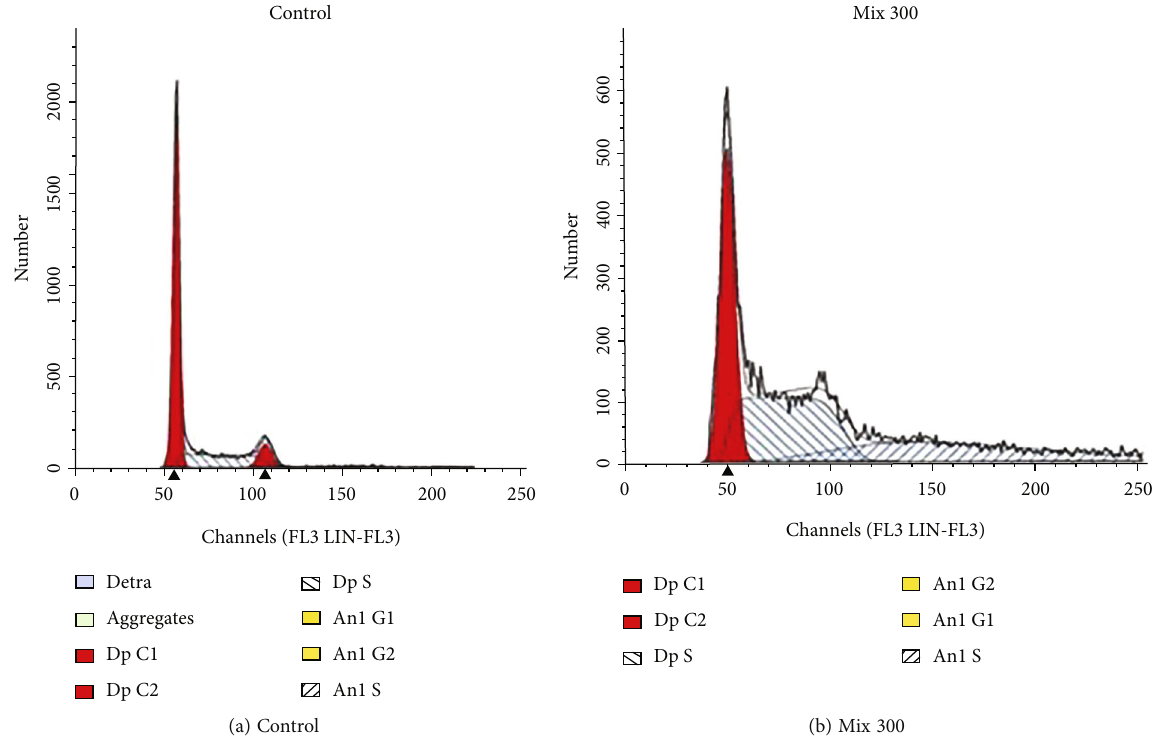
Figure 8: Diploid-tetraploid cycle modeling of representative cell cycle histograms of control (Dip. S: S phase of the diploid population, An1. S: S phase of the aneuploid